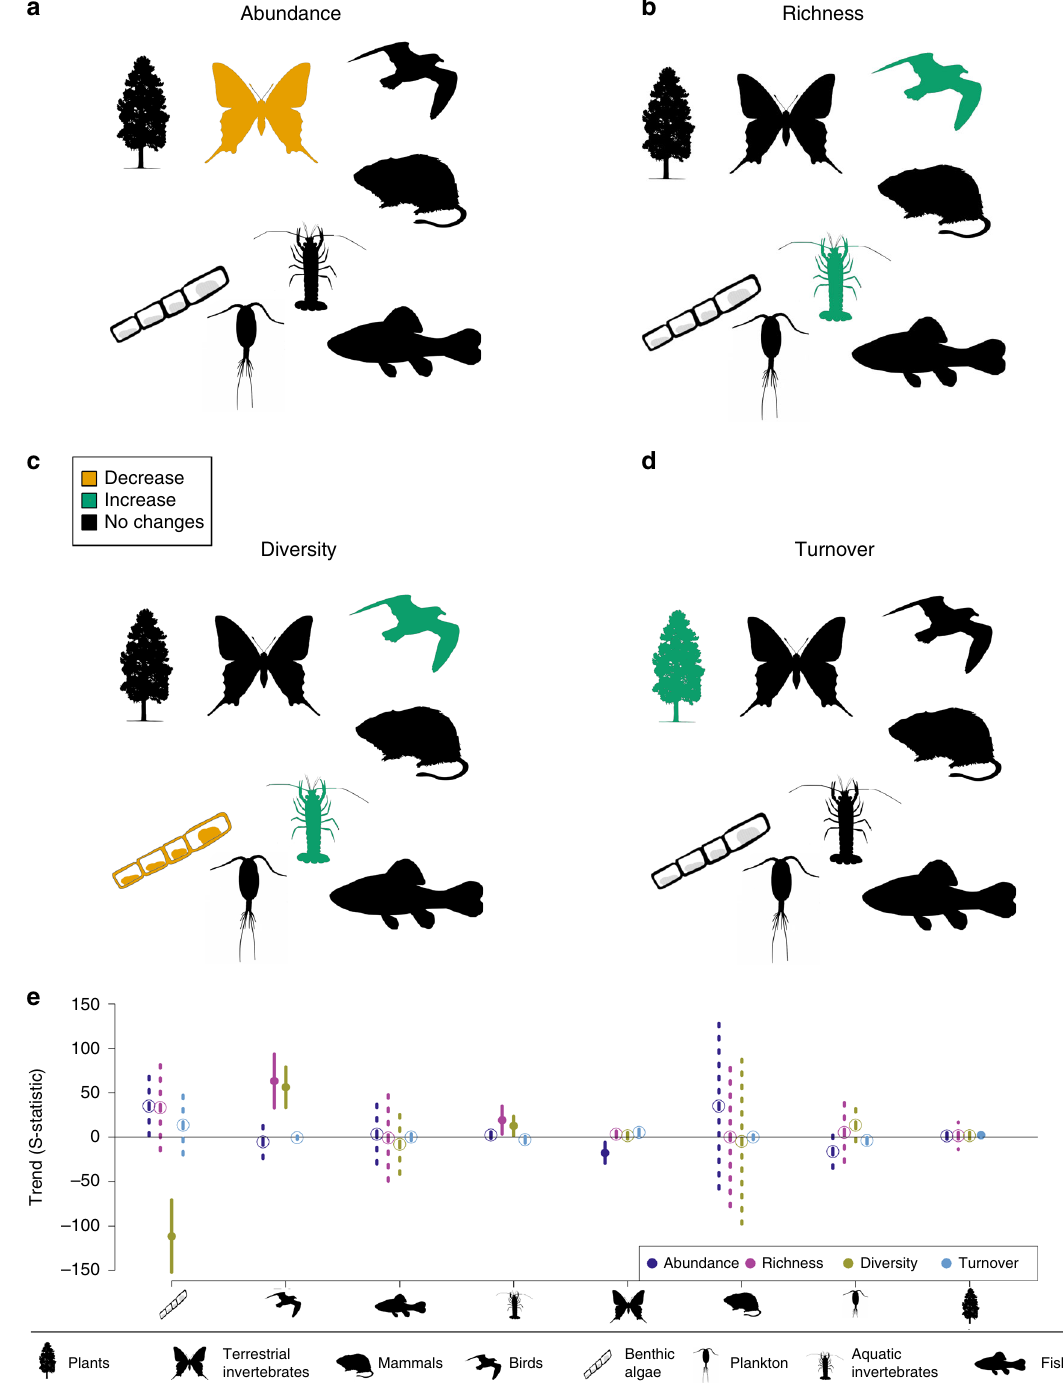
Fig. 4 Biodiversity trends for the studied taxonomic groups. The results of meta-analysis mixed models are shown for the four studied biodiversity metrics: abundance ( a ), richness ( b ), diversity ( c ) and turnover ( d ). Green: signi fi cant increasing trends ( p ≤ 0.05); orange: signi fi cant declining trends ( p ≤ 0.05); black: no signi fi cant trends ( p > 0.05). Drawings from phylopic.org. e values of S-statistics (model estimated mean, error bar: + / − C.I.). Dark blue: abundance, pink: richness, yellow: diversity, light blue: turnover. Solid line and dot: p ≤ 0.05; dashed line and open circle: p > 0.05. Number of time series ( n ): Plants: 34, terrestrial invertebrates: 53, mammals: 1, birds: 16, benthic algae: 7, plankton: 9, aquatic invertebrates: 38, fi sh: 3. Source data are provided as a Source Data fi